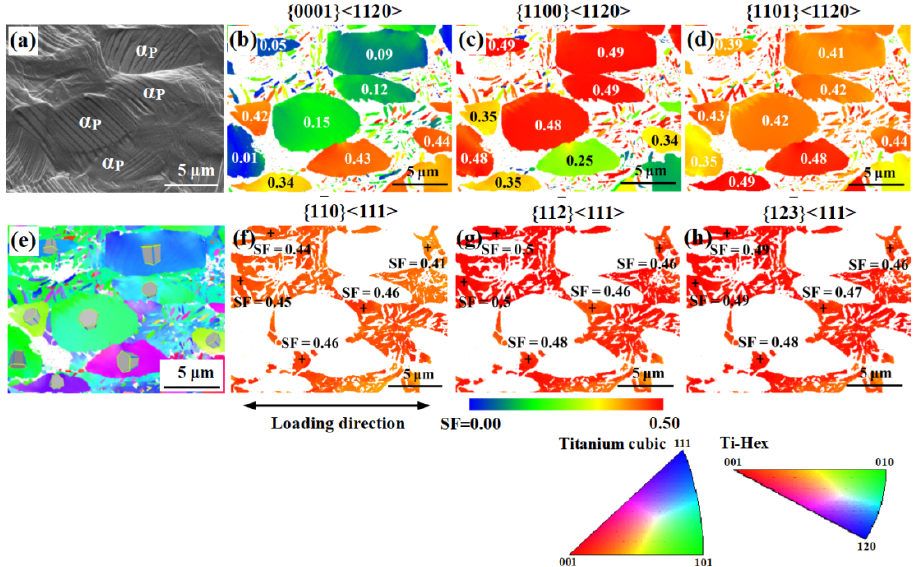
Figure 10. EBSD images of bimodal microstructure after stretching in situ; ( a ) SEM image showing many parallel SBs in the α P phase; ( b ) SF map of basal slip for α ; ( c ) SF map of prismatic slip for α ; ( d ) SF map of pyramidal slip for α ; ( e ) the inverse pole figure map; ( f ) SF map of β for {110}<111> slip; ( g ) SF map of β for {11 2 }<111> slip; ( h ) SF map of β for {12 3 }<111> slip.